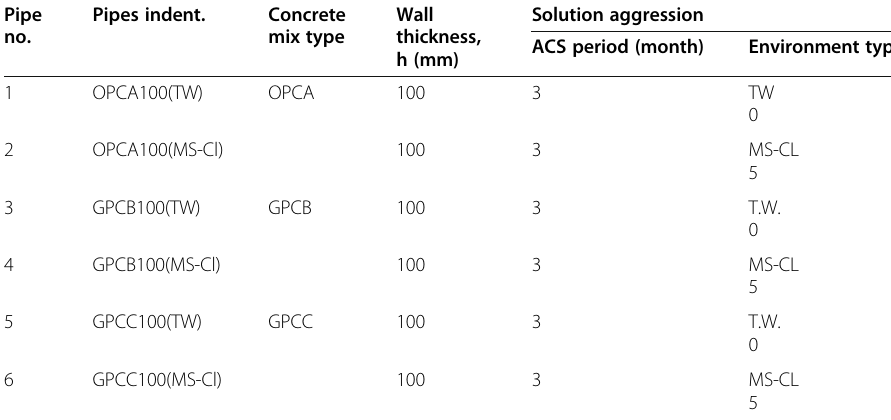
Table 6 Main properties of the tested pipes Pipe no.